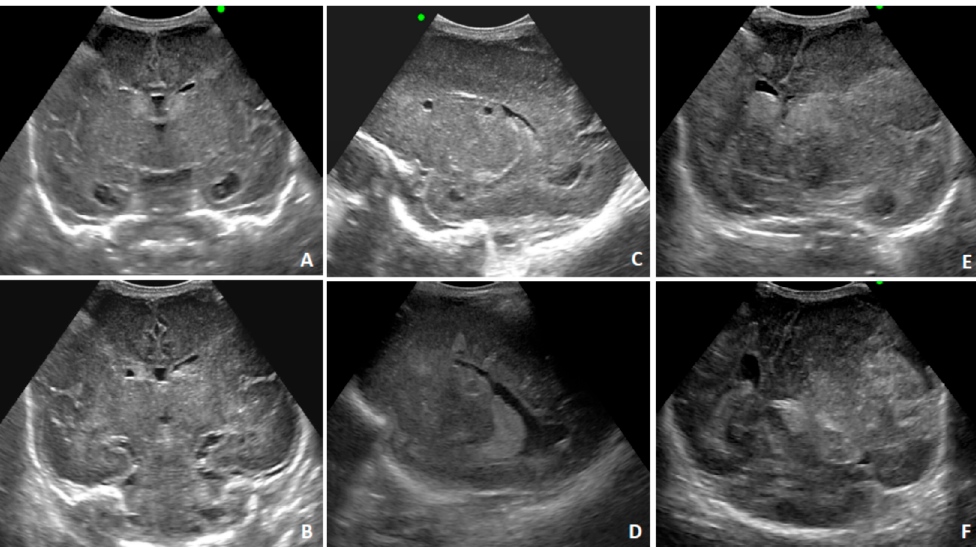
Figure 4. Transfontanellar ultrasound findings for Case 2 at birth. Second day after birth; ( A – D ): multiple subependymal cysts; temporal horn cysts. Bilateral microhemorrhagic alterations in the thalamic–caudate groove (germinal matrix). Diffuse white matter hyperechogenicity. Two days later; ( E , F ): bulky hemorrhagic lesions in left cerebral hemisphere with an extraparenchymal component appearing, causing an important mass effect and contralateral midline shift.